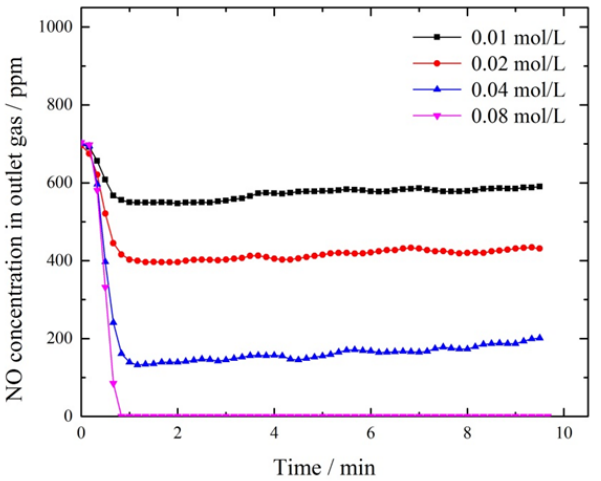
Figure 5. The effect of NaClO 2 concentration on the change of NO concentration in outlet gas during the denitrification process.